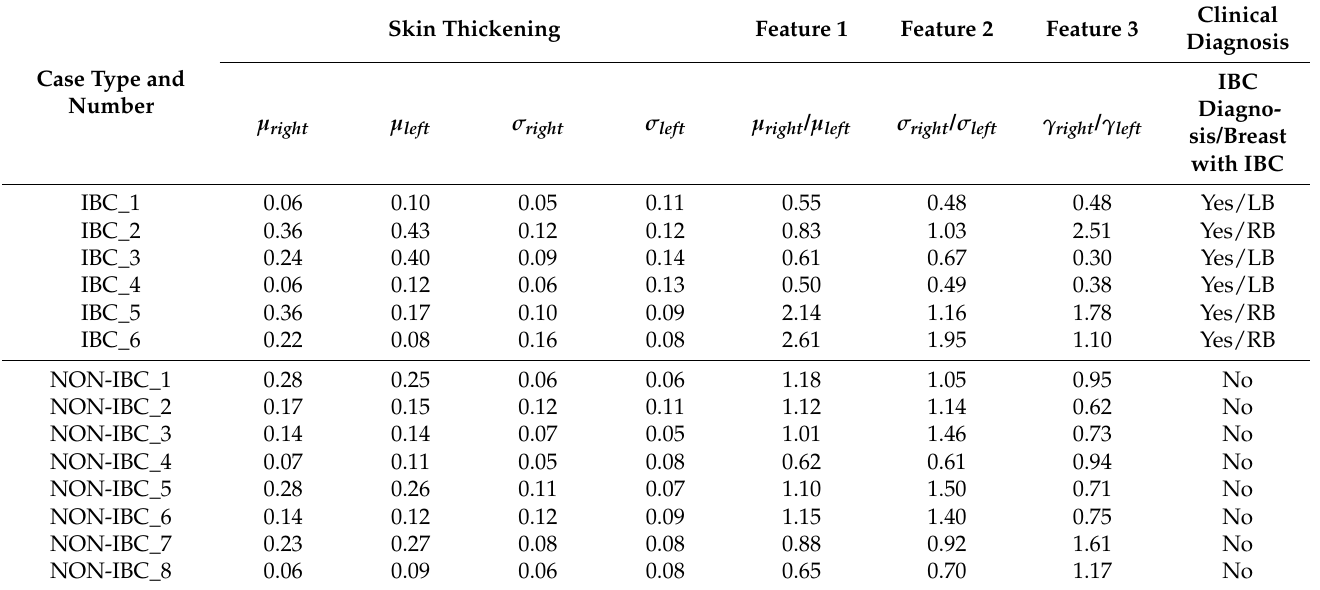
Table 1. Skin thickening and breast density ratios of IBC and non-IBC cancer cases, including MLO and CC views. RB: Right breast, LB: Left breast.